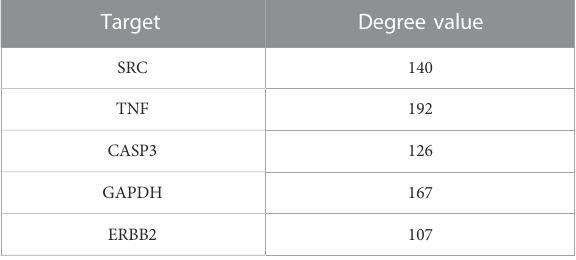
TABLE 1 Shared key targets of sepsis and